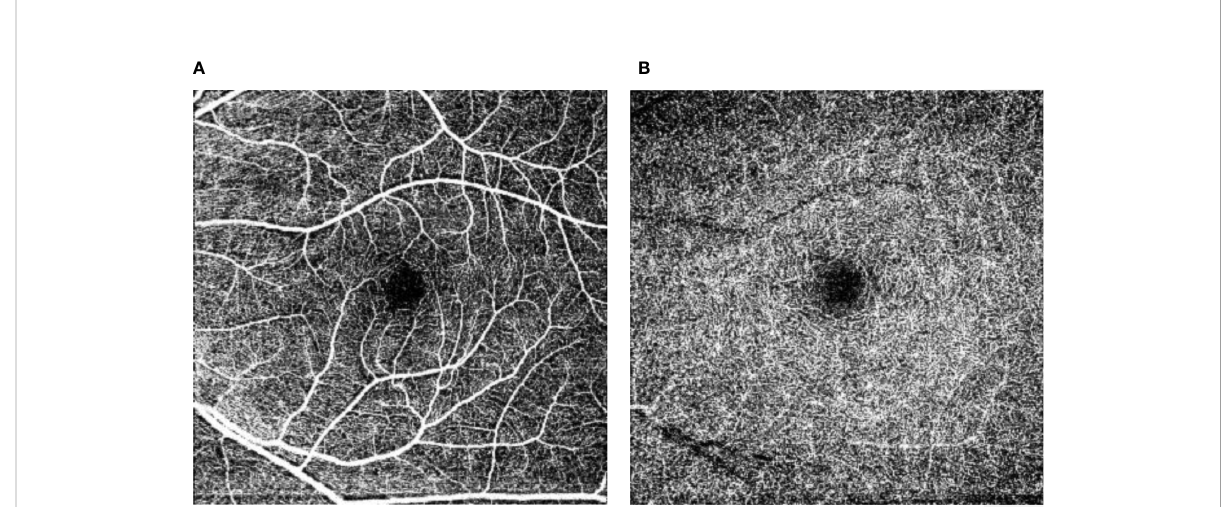
FIGURE 2.6 Retinal vascular density and foveal avascular zone. Figure 2.6 shows the super fi cial capillary networks (A) and the deep capillary networks (B) in the perifoveal area. The central black area is the perifoveal avascular zone, where a larger perifoveal avascular area re fl ects less capillary perfusion at rest. In addition, from these images the capillary perfusion at rest can be estimated as the “ vascular density ”